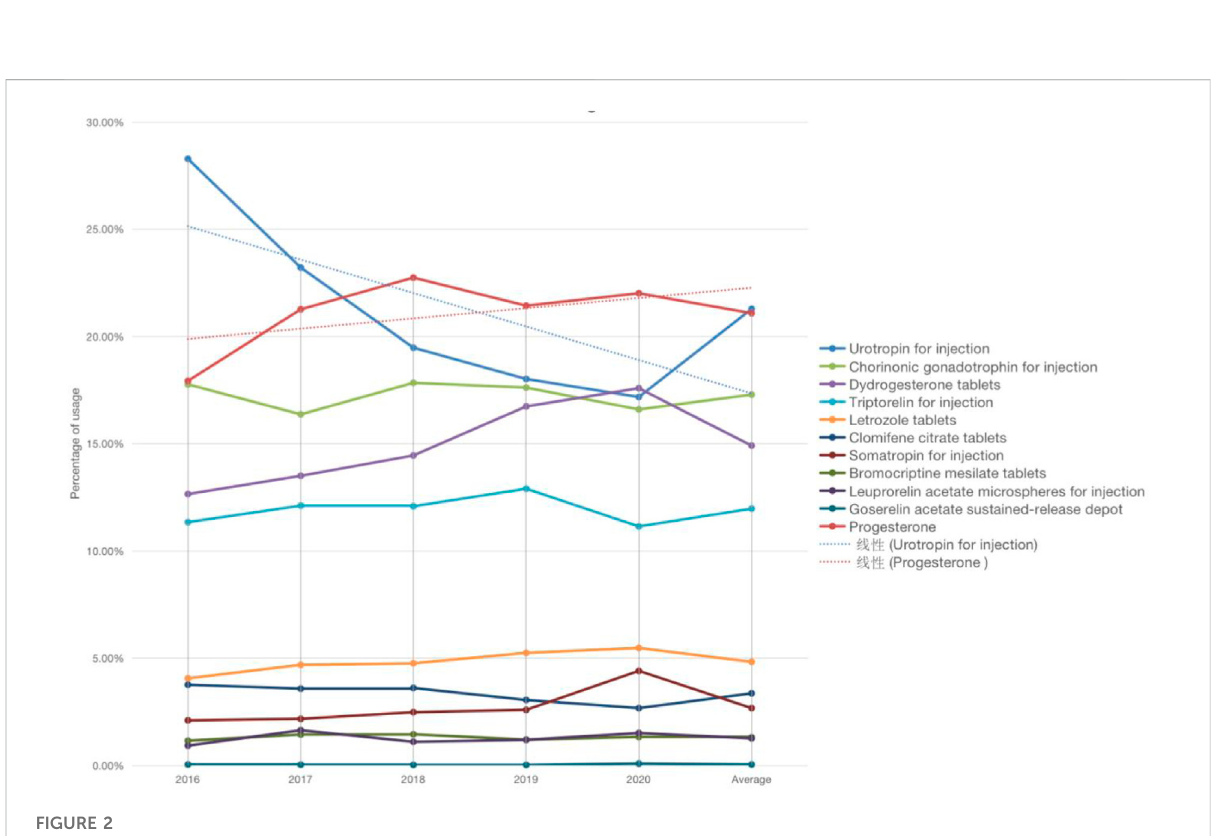
FIGURE 2 Trends in main therapeutic drugs